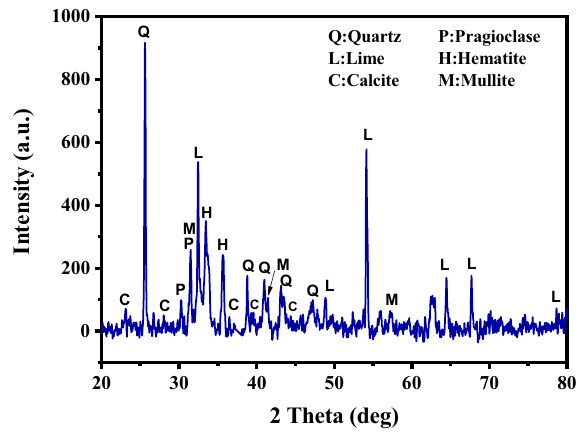
Figure 2. XRD pattern of fly ash annealed at 80 °C.